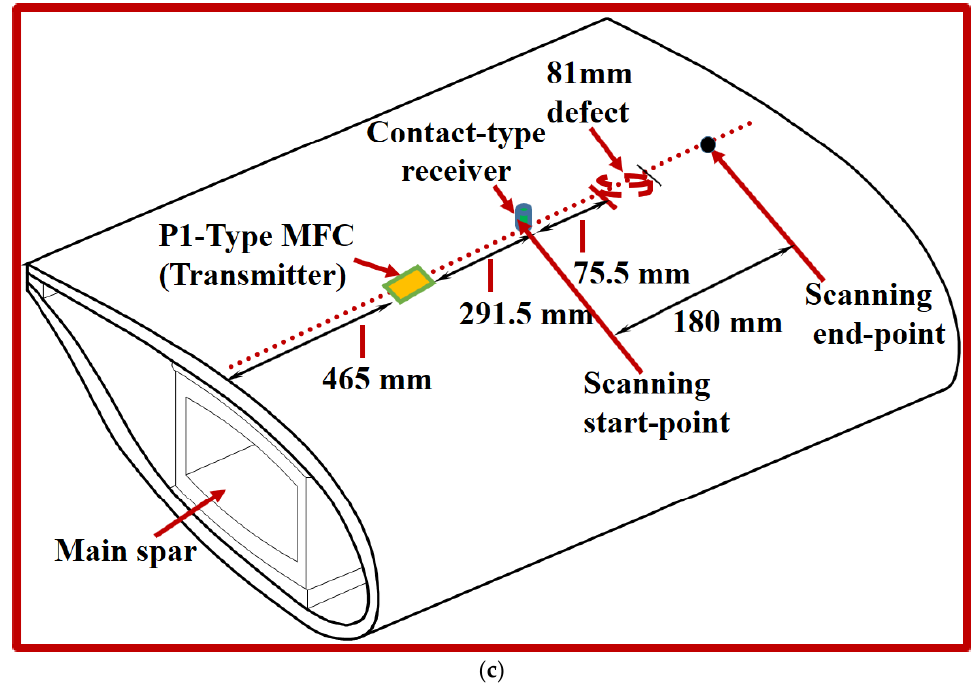
Figure 1. GFRP sample and arrangement of transducers: ( a ) front view of the sample where scanning is performed; ( b ) inner view of sample where defect of 81 mm diameter is present and MFC transducer is glued; and ( c ) schematic showing the segment of WTB, arrangement and position of transducers and location of defect. Table 1. Parametric specifications of LF ultrasonic